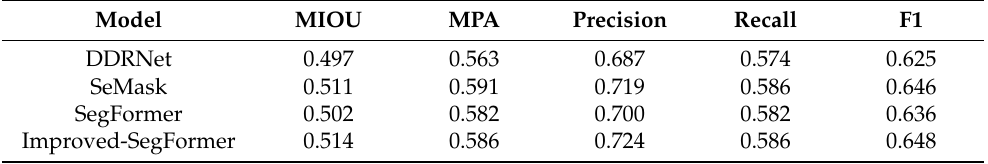
Table 2. Relevant evaluation indexes of SegFormer and Improved-SegFormer. Model